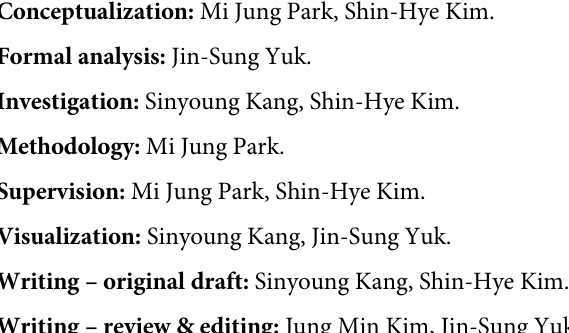
S1 Table. The annual incidence of central precocious puberty according to the sex and age at diagnosis. New cases of central precocious puberty were defined as those children